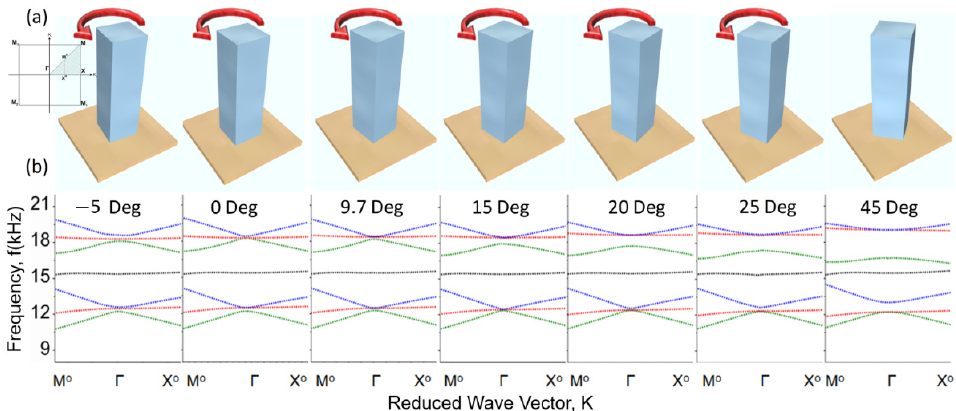
Figure 3. ( a ) Geometric representation of square rods rotated counterclockwise (CCW) at θ = − 5°, 0°, 5°, 9.7°, 15°, 20° and 25°, embedded in air host. This angular tuning has been performed for the entire 90° CCW to demonstrate the Dual-Dirac phenomenon, among which only the above-mentioned are reported here, ( b ) The respective band structure dispersion relation for above-mentioned rotations for the rods, demonstrating the gradual process of undergoing triple degeneracy for DRA and DRB for θ = 9.7°, generating a Dual-Dirac phenomenon. Notably, both the deaf bands (red) remain almost fixed in position with respect to the frequency.